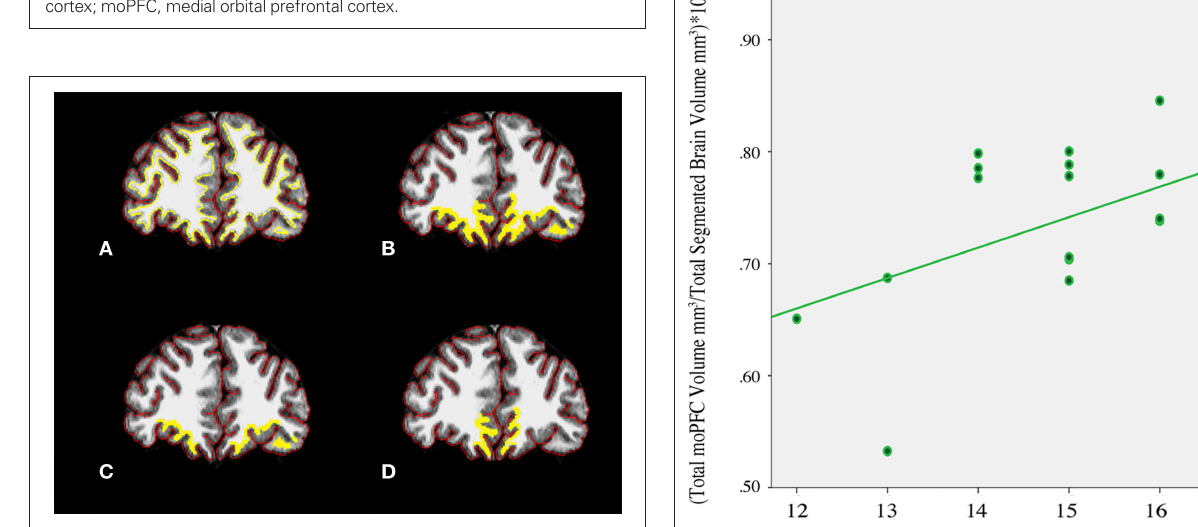
FiguRE 1 | inferior and sagittal 3-D representations with ROis and reference regions employed in FreeSurfer including: (A) moPFC in red, loPFC in dark green, and frontal pole in purple and (B) medial view showing superior PFC in light green, moPFC in red, and frontal pole in purple. ROI, region of interest; PFC, prefrontal cortex; loPFC, lateral orbital prefrontal cortex; moPFC, medial orbital prefrontal cortex.